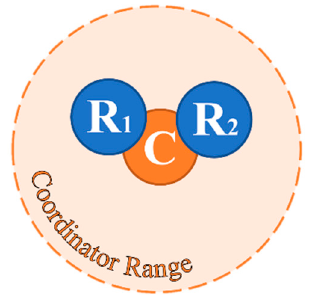
Figure 10. Representation of Case A.1.